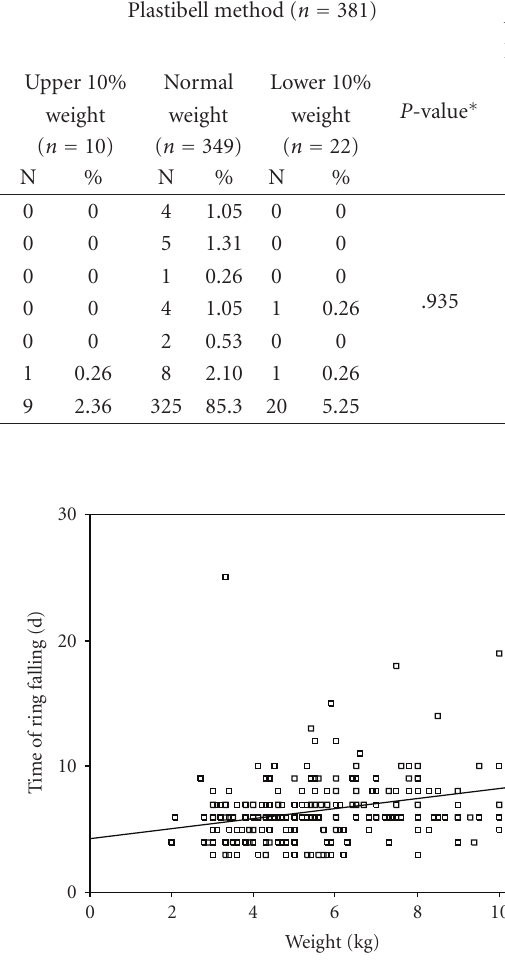
Figure 1: Correlation between age of subjects and the bell separation time (Pearson correlation = 0.24, P < . 001).